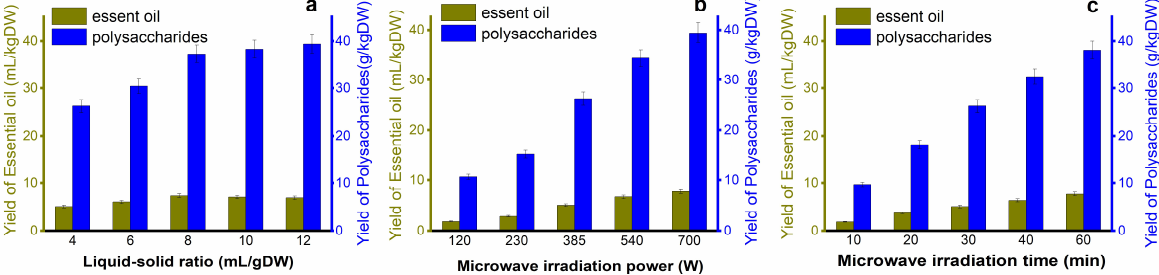
Figure 3. Influence of each factor on the yield (a: Liquid-soild ratio; b: microwave irradiation power and c: microwave irradiation)